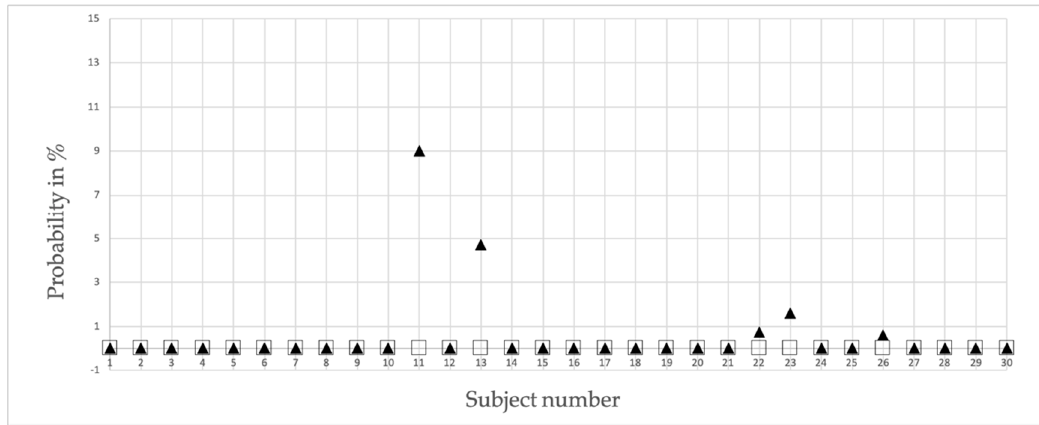
Figure 4. False positive detection probability chart displaying the individual percentages of all subjects. Squares = Super attractor versus the first run of the same person and filled triangles = Super attractor versus the second run of the same person. When probability is zero, squares are partly hidden by filled triangles.